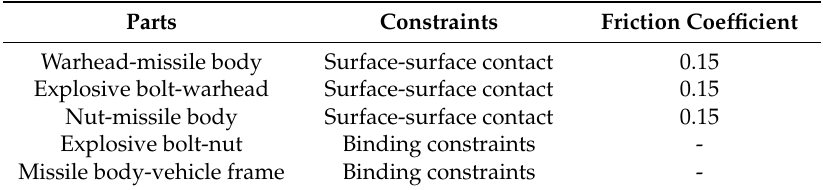
Figure 6. Loads of the missile vehicle.